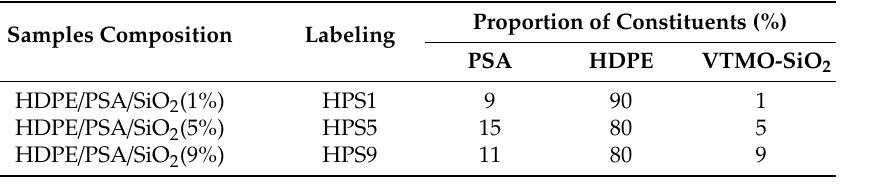
Table 2. Di ff erent mixture ratios for the composite preparation.